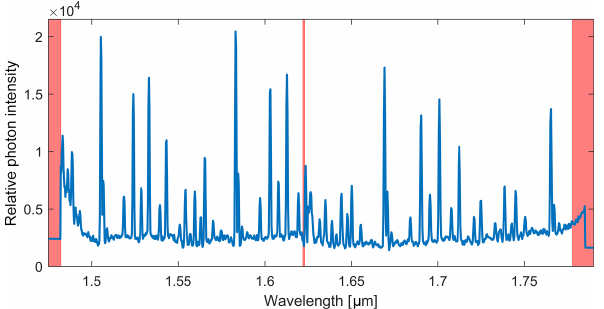
Figure 2. H-band spectrum of atmospheric OH extracted from the data frame presented in Fig. 1. Red shading highlights parts of the spectrum not used in the subsequent rotational temperature